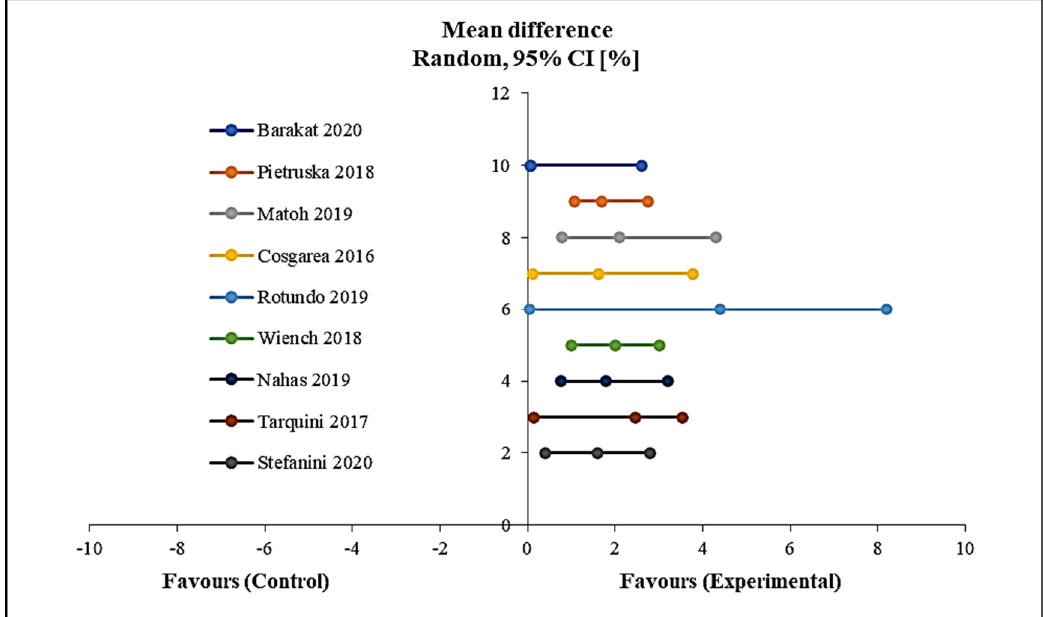
Figure 8. Forest plot showing the mean width of keratinised tissue.